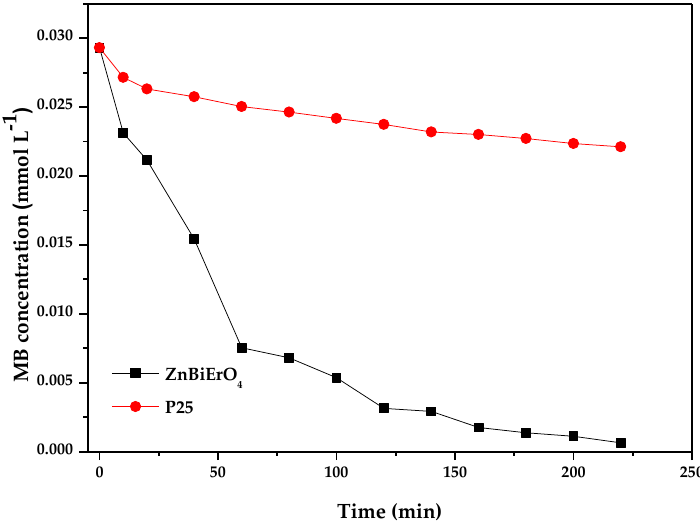
Figure 19. Photocatalytic degradation of methyl blue with ZnBiErO 4 or P25 as catalyst under sunlight irradiation.